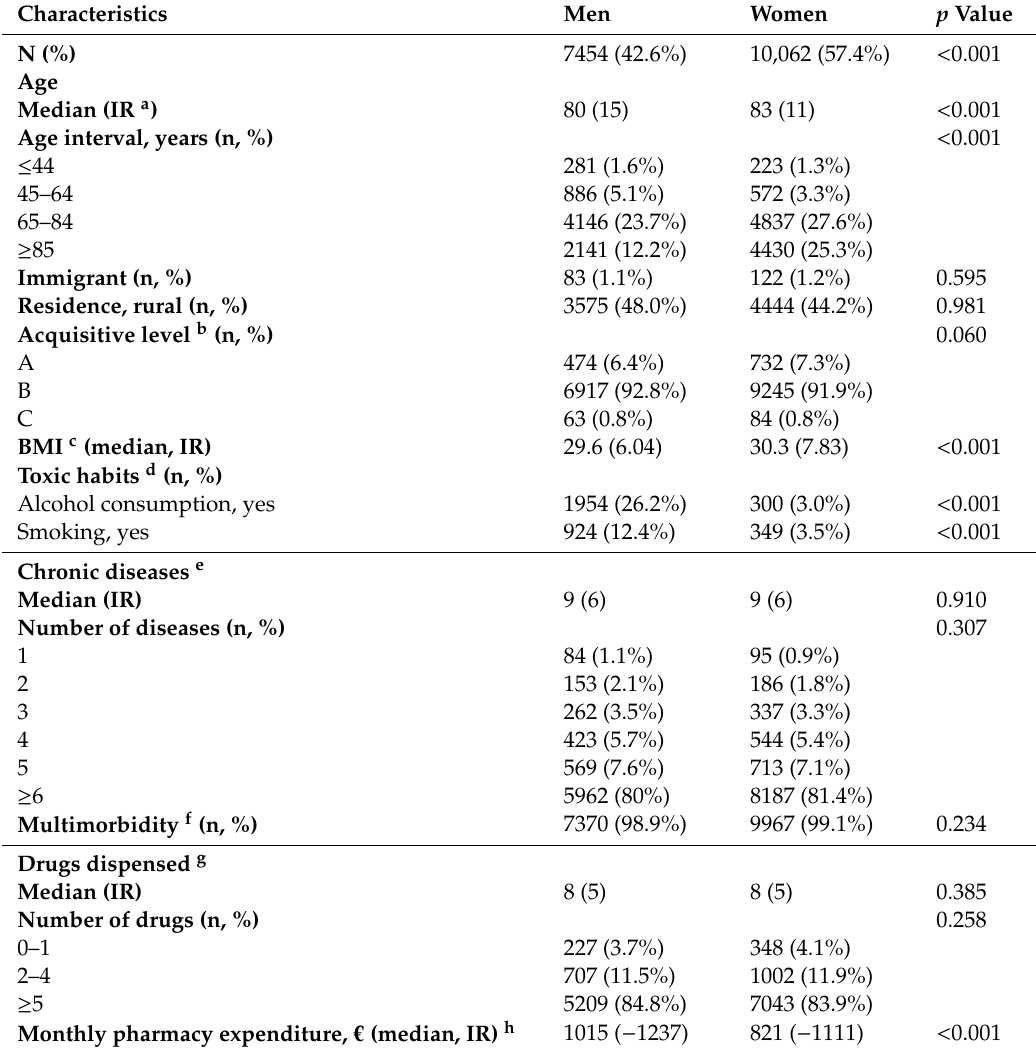
Table 1. Demographic and clinical description of the study population with heart failure based on their